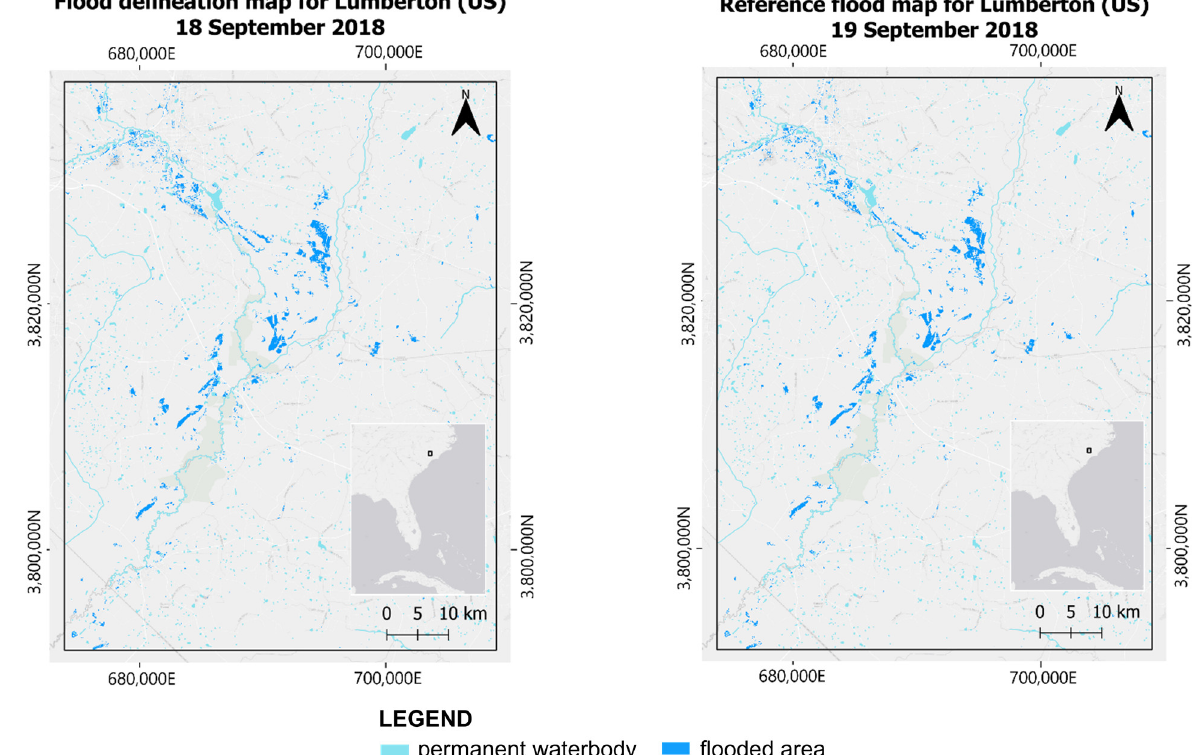
Figure 10. Final flood delineation map ( left panel ) and reference flood map ( right panel ) for the Lumberton area (US). CRS: WGS84/UTM zone 17 N. Basemap data: Esri Gray (light) © Esri.